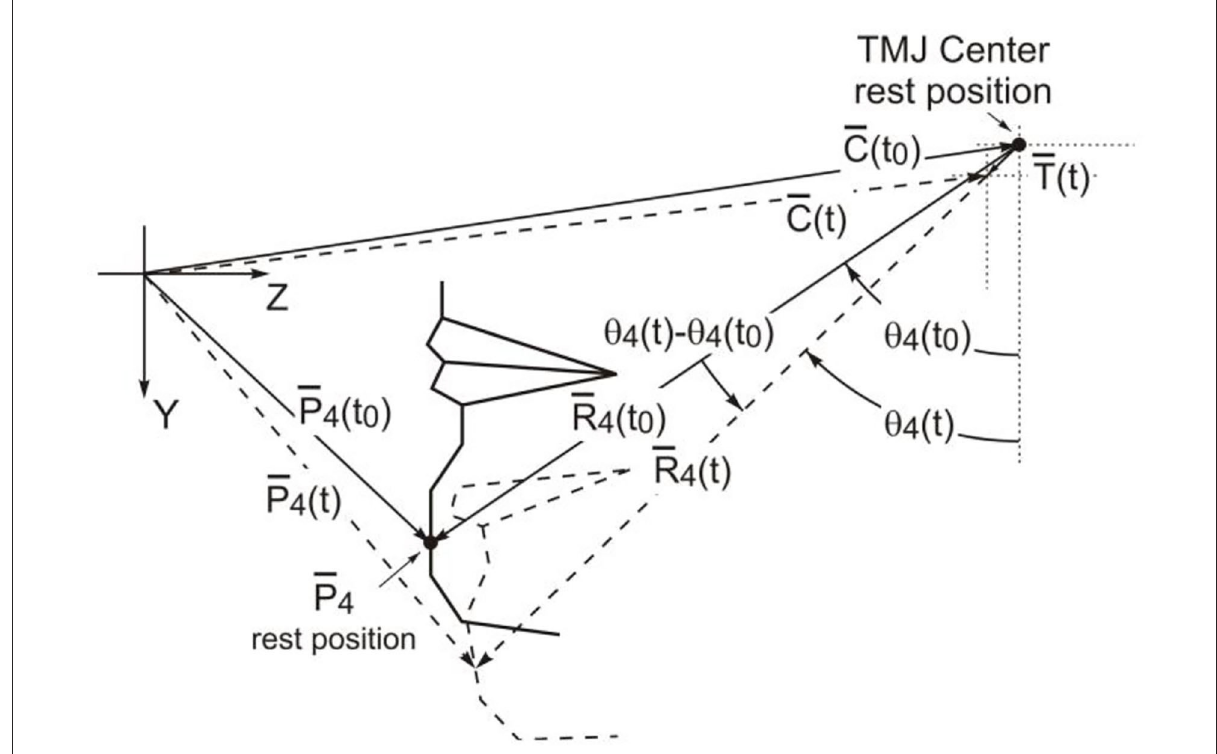
FIGURE4 The condyle motion model defined by De Martino.